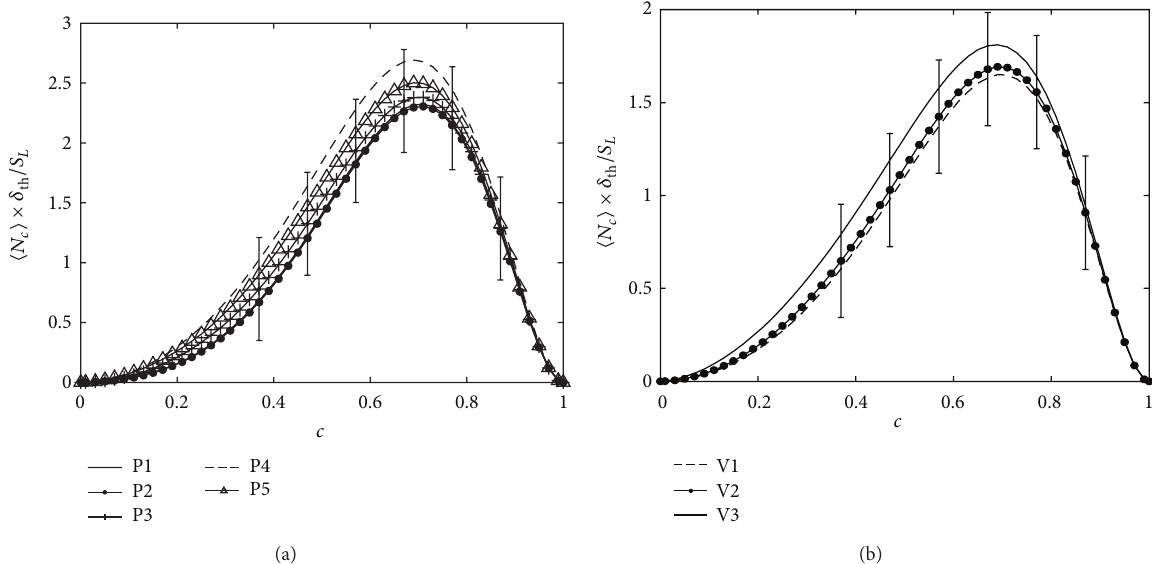
/𝑆 𝑐 values across the flame front for (a) statistically planar cases with 𝐿 conditional on th